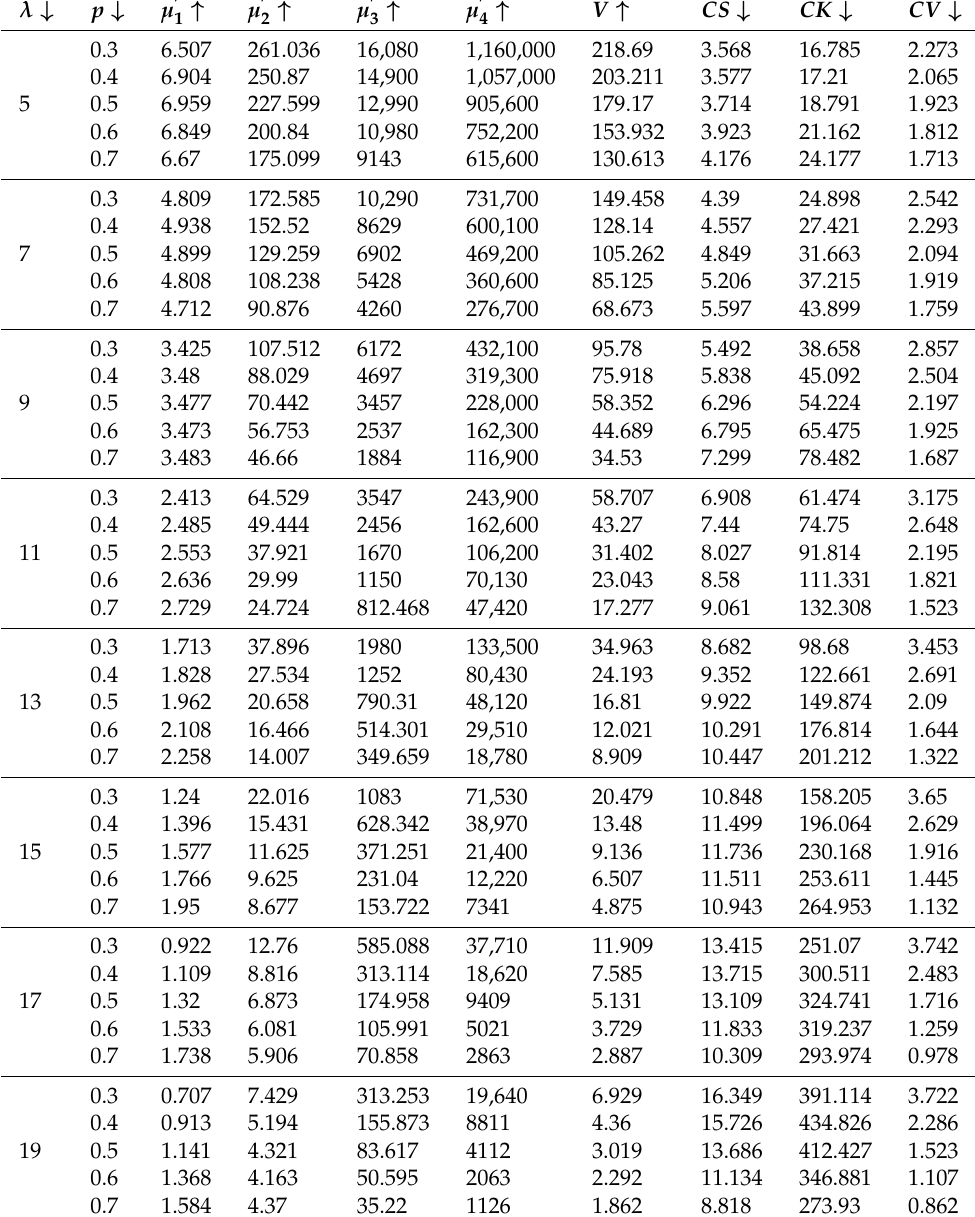
, µ (cid:48) , µ (cid:48) , µ (cid:48) , V , CS , CK and CV for the FB model at β = 0.5 and n = 2 3 1 4